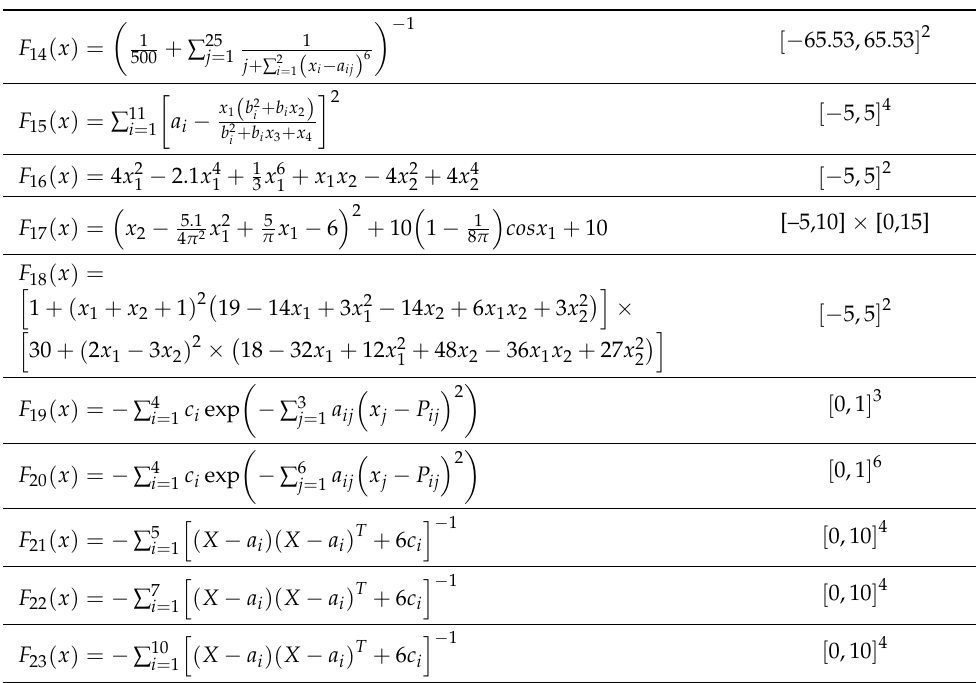
Table 4. Multimodal test functions with fixed dimensions.